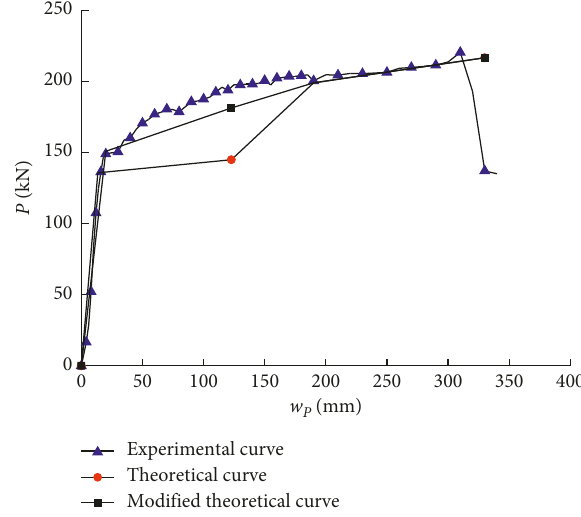
Figure 13: Resistance curves of the CFSTSBF